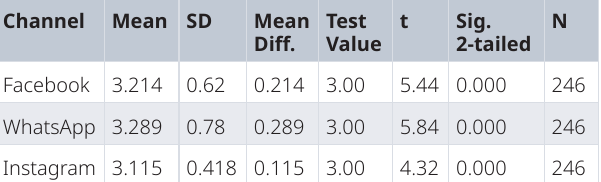
Table 5. Use of social media in marketing agricultural products and sales turnover.